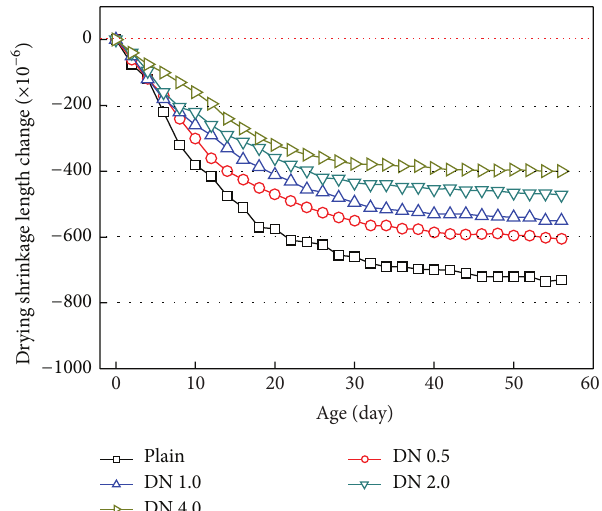
Figure 10: Compressive strength by age for varying amounts of shrinkage reducing agent.